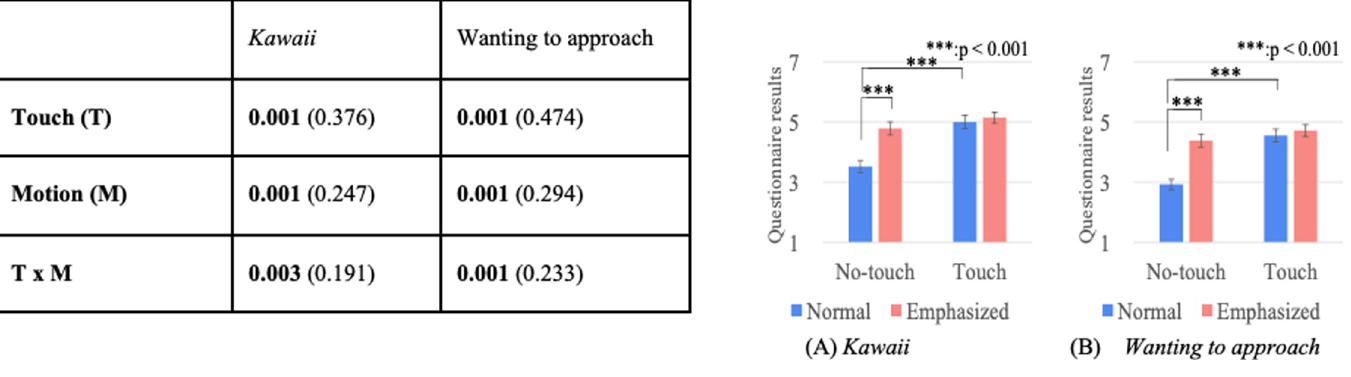
Fig 6. Kawaii and wanting to approach